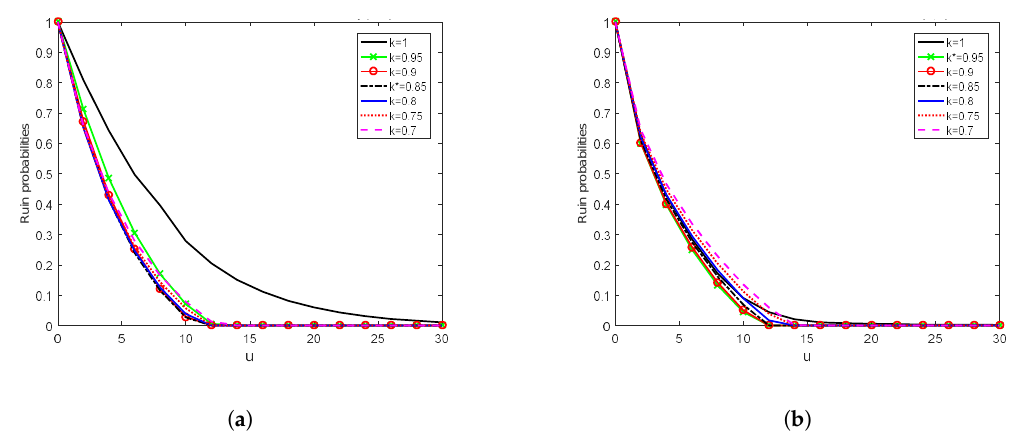
Figure 5. Ultimate ruin probabilities for the DPM compounded by proportional reinsurance and investments of Black–Scholes type; ( a ) DPM with stochastic interest, Exp(0.5) claims; ( b ) DPM with stochastic interest, Par(3,2)